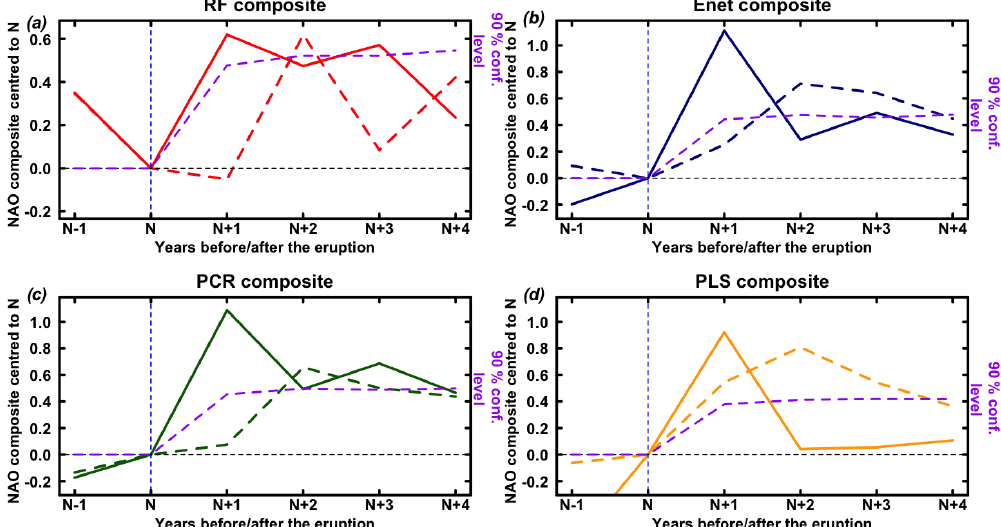
Figure 11. Superposed epoch analysis of the NAO response from 2 years ( N − 1) before to 5 years after ( N + 4) the largest volcanic eruptions used by Ortega et al. (2015) (10 eruptions) and the 11 largest from Sigl et al. (2015). All of the composites are centred to their values at the year of the volcanic eruption occurrence. (a) Red line: composite for RF reconstruction response to Sigl et al. (2015) volcanic eruptions. Dashed red line: composite for RF reconstruction response to Ortega et al. (2015) volcanic eruptions. Dashed purple line: Monte Carlo 90% confidence level (Rao et al., 2019, Sect. S4). (b) Blue line: composite for Enet reconstruction response Sigl et al. (2015) volcanic eruptions. Dashed blue line: composite for Enet reconstruction response to Ortega et al. (2015) volcanic eruptions. Dashed purple line: Monte Carlo 90% confidence level (Rao et al., 2019, Sect. S4). (c) Green line: composite for PCR reconstruction response Sigl et al. (2015) volcanic eruptions. Dashed green line: composite for PCR reconstruction response to Ortega et al. (2015) volcanic eruptions. Dashed purple line: Monte Carlo 90% confidence level (Rao et al., 2019, Sect. S4). (d) Orange line: composite for PLS reconstruction response Sigl et al. (2015) volcanic eruptions. Dashed orange line: composite for PLS reconstruction response to Ortega et al. (2015) volcanic eruptions. Dashed purple line: Monte Carlo 90% confidence level (Rao et al., 2019, Sect.